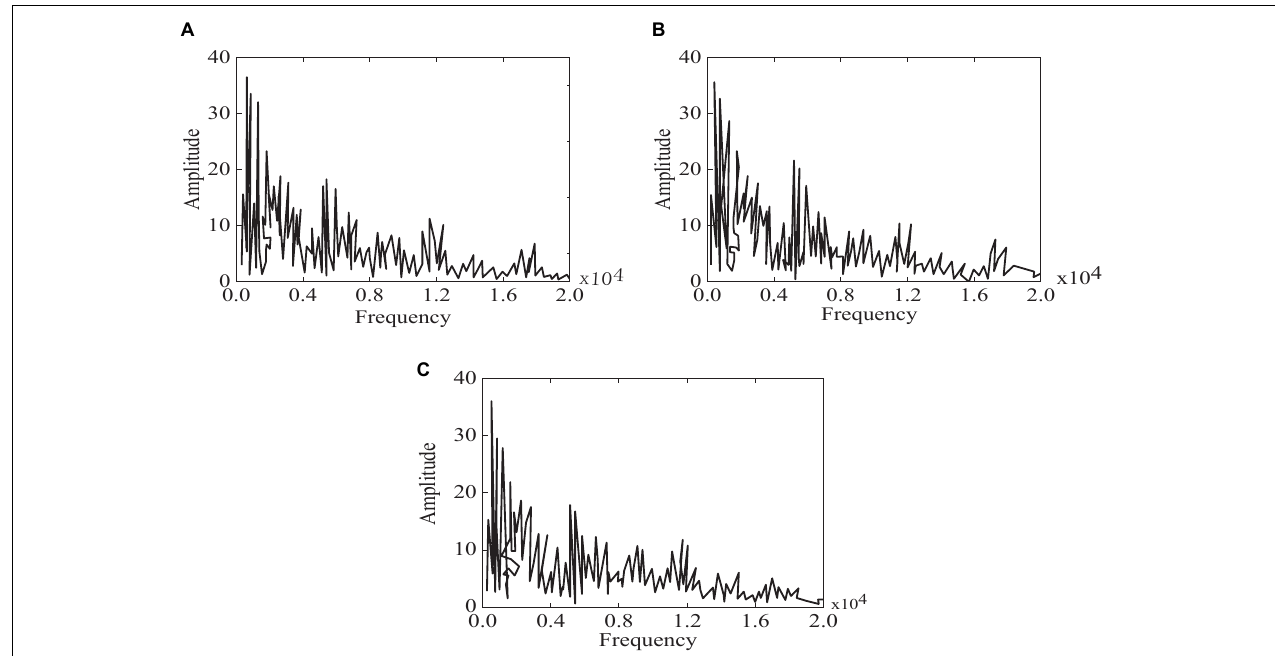
FIGURE 9 | Spectrum diagram of original music, RBM, and the method proposed (A) original music; (B) RBM; (C) the method proposed. (A) Is a spectrum diagram of the original music. It reveals that the value of the original sample music does not exceed 20 when the frequency is about 5,000 HZ, but it significantly exceeds in (B,C) suggests that the music spectrogram generated by using the method proposed is consistent with the original music spectrogram, both in the overall frequency distribution and the sample frequency distribution.